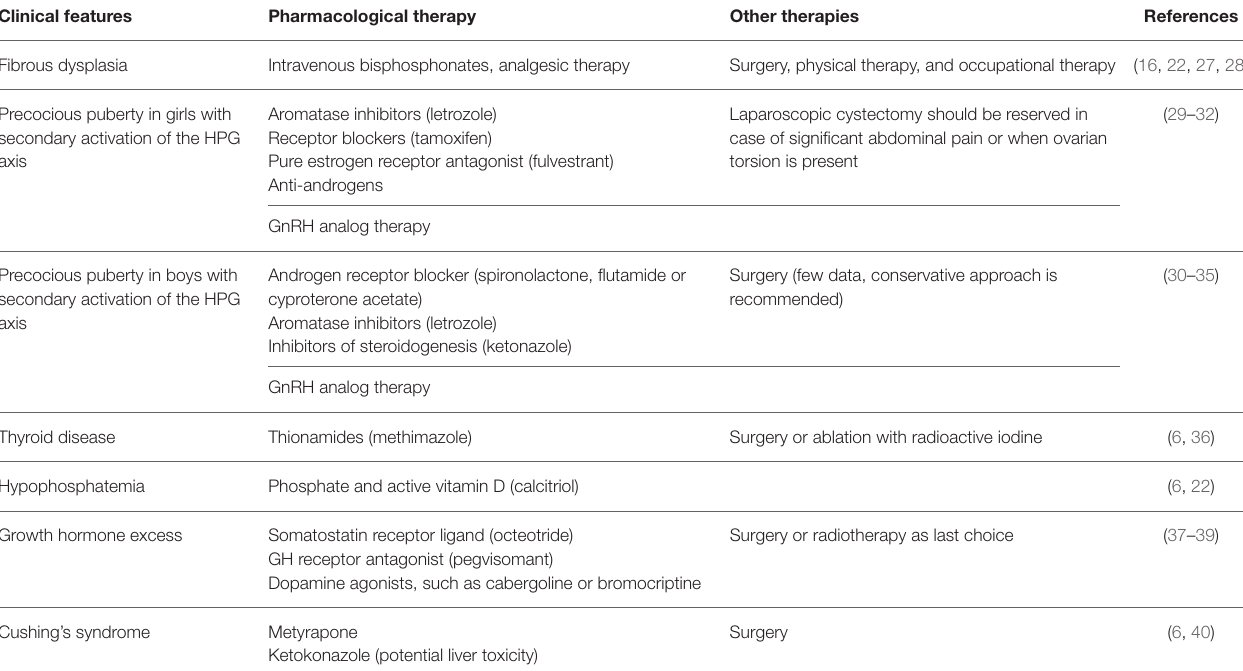
TABLE 1 | Therapy of clinical manifestations in children with